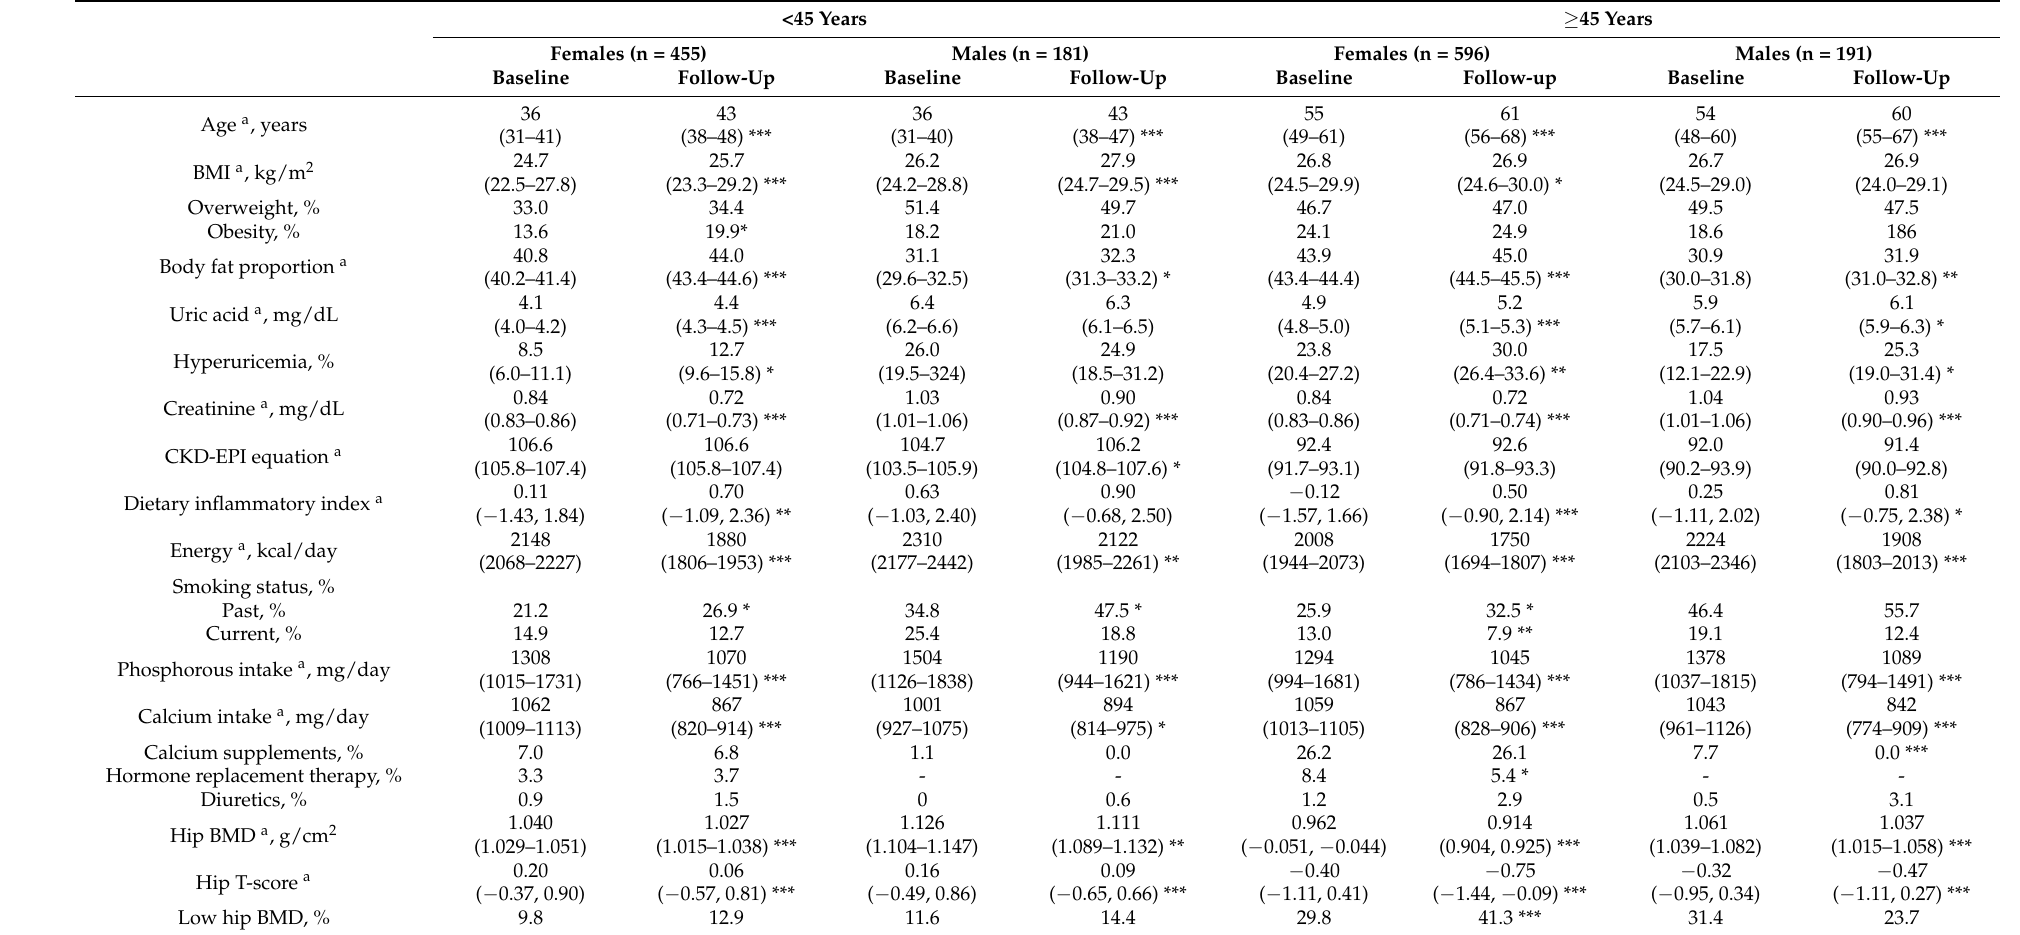
Table 2. Baseline and follow-up characteristics of the Health Workers Cohort Study (HWCS) by sex and age groups (n =